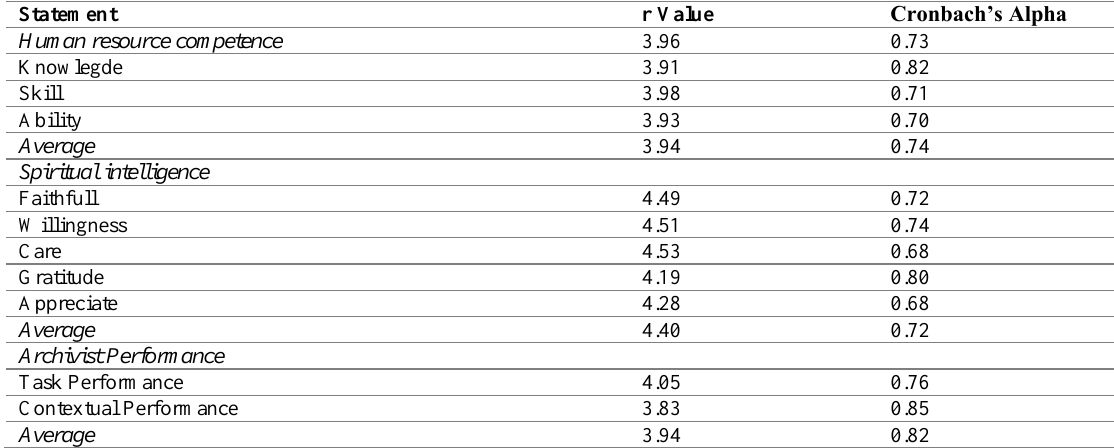
Table 1 : Validity and Reliability Test